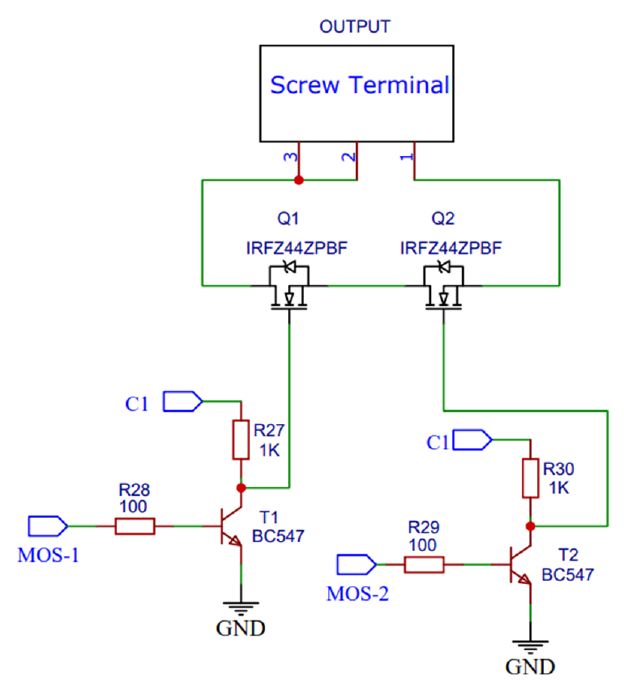
Figure 7. Overcharge and overdischarge control